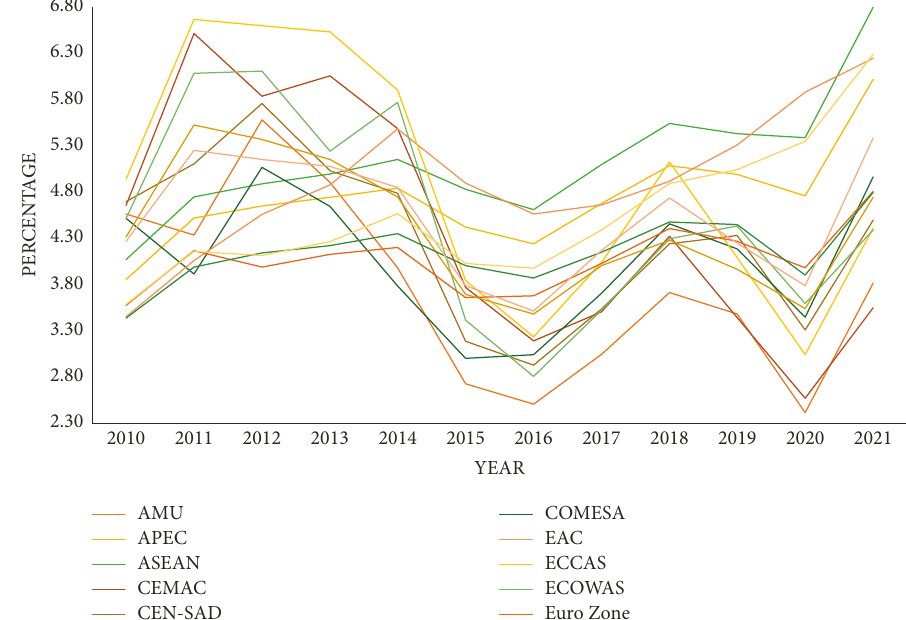
Figure 1: Intraregional trade comparison based and calculated by UNCTAD data. https://unctadstat.unctad.org/wds/TableViewer/